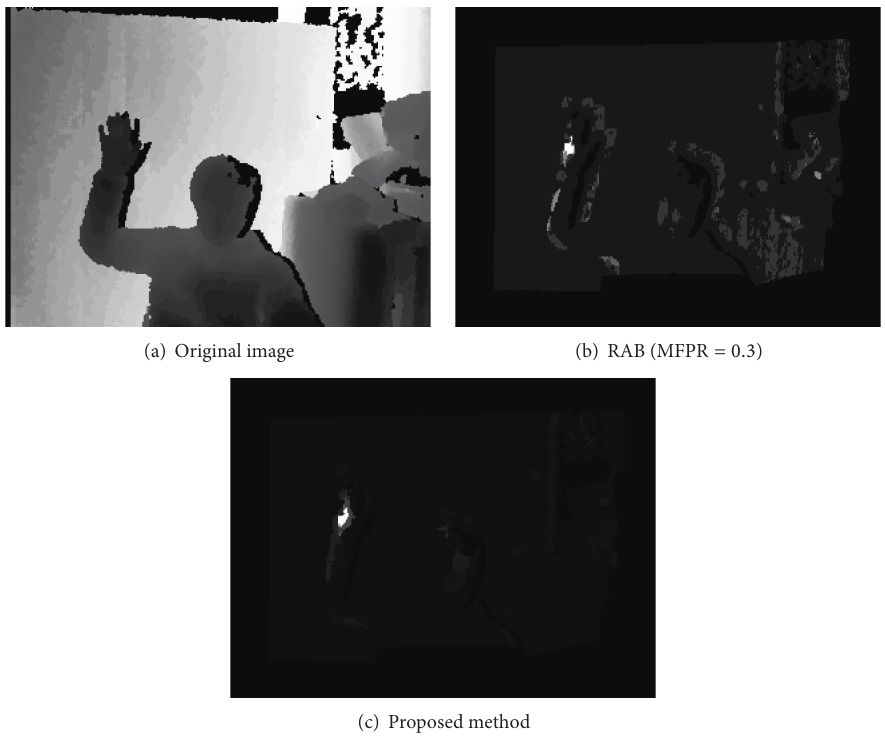
Figure 13: Computational performances.